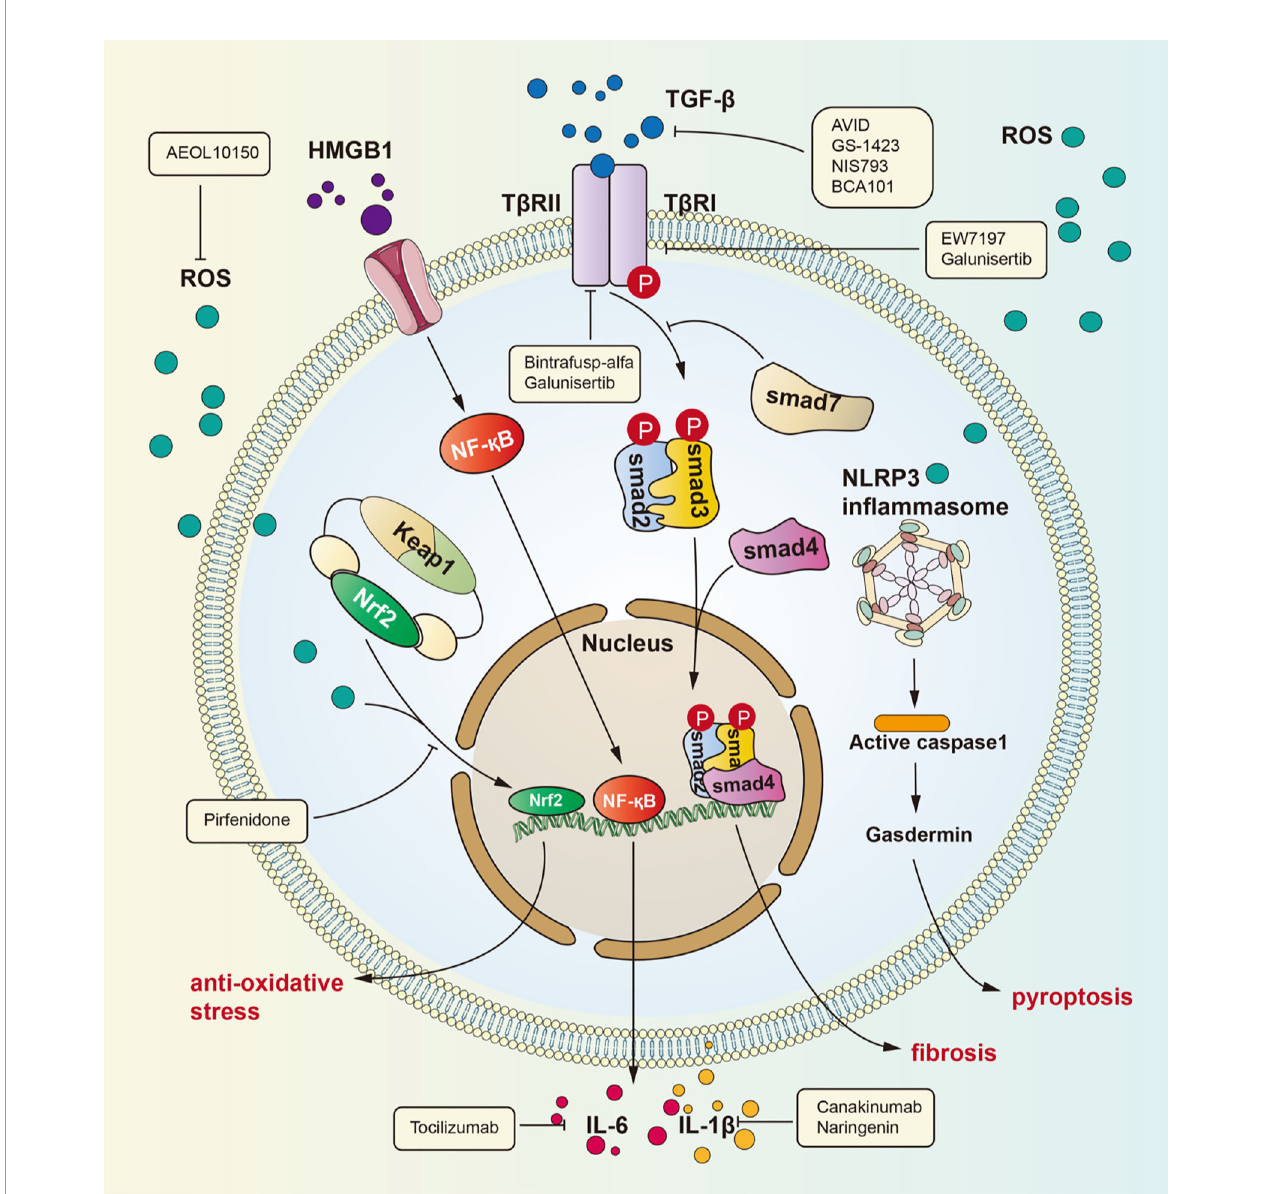
FIGURE 1 | Signaling pathways for radiation-induced lung injury. Radiation induces lung injury via these ways showed in the fi gure. Activated HMGB1 binds to TLR4. It leads to NF-kB into nucleus and interaction with DNA, therefore promoting IL-1 b and IL-6 expression which can cause lung in fl ammation. TGF- b can be activated by ROS. Activated TGF- b can bind to TGF- b RII therefore phosphorylating Smad2 and Smad3 which can form a complex with Smad4. The complex can regulate gene expression to promote fi brosis. ROS is produced after radiation and cause dissociation of NrF2 form complex. Dissociated NrF2 can regulate gene expression to suppress oxidative